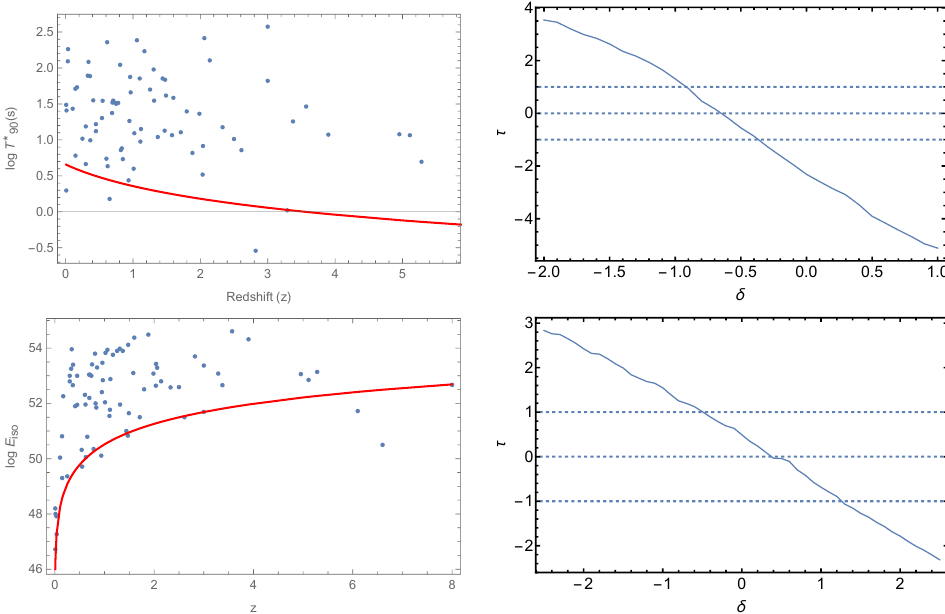
Figure 3. The ( upper left ) panel shows the values of log T ∗ log T ∗ in the rest-frame in red. The ( upper right ) panel shows the Kendall τ vs. the slope of the 90 evolutionary function with 1 σ errors shown with dashed blue lines. As with the upper panels, the ( lower left ) panel shows values of log E iso vs. redshift in blue with the limiting line in red, and the ( right ) panel shows the Kendall τ vs. slope of the evolutionary function with 1 σ errors as dashed blue